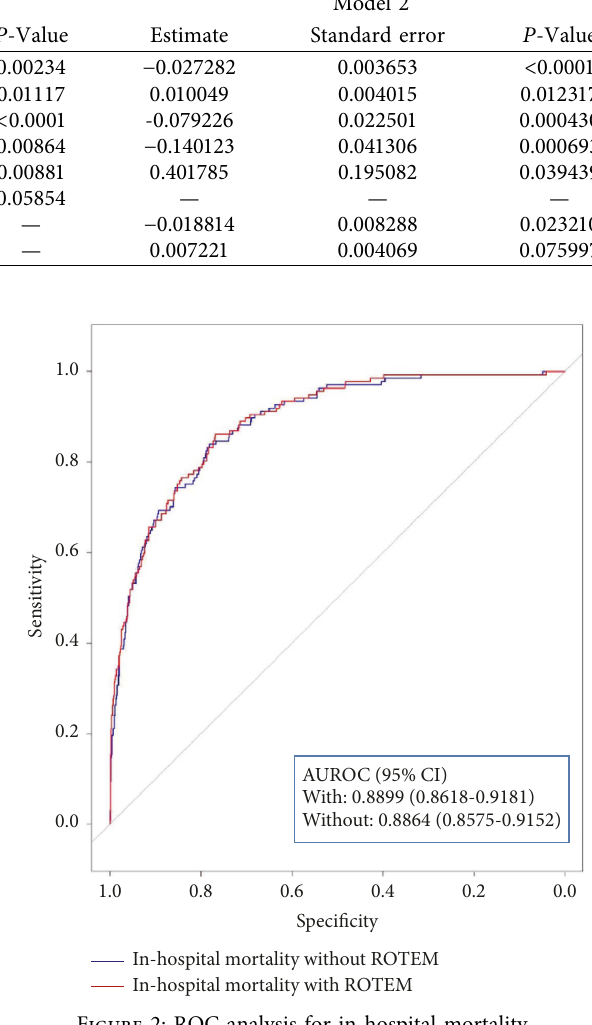
Figure 1: ROC analysis for MT. Figure 2: ROC analysis for in-hospital